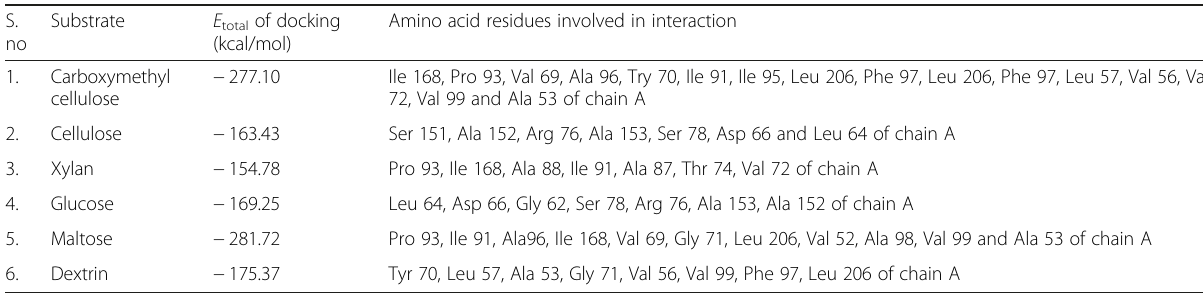
Table 3 Binding energies ( E total ) for the interaction of carboxymethyl cellulose, cellulose, xylan, glucose, maltose, and dextrin with PW2 endoglucanase and the sites of interaction on the enzyme S. Substrate E total of docking Amino acid residues involved in interaction no (kcal/mol) 1.